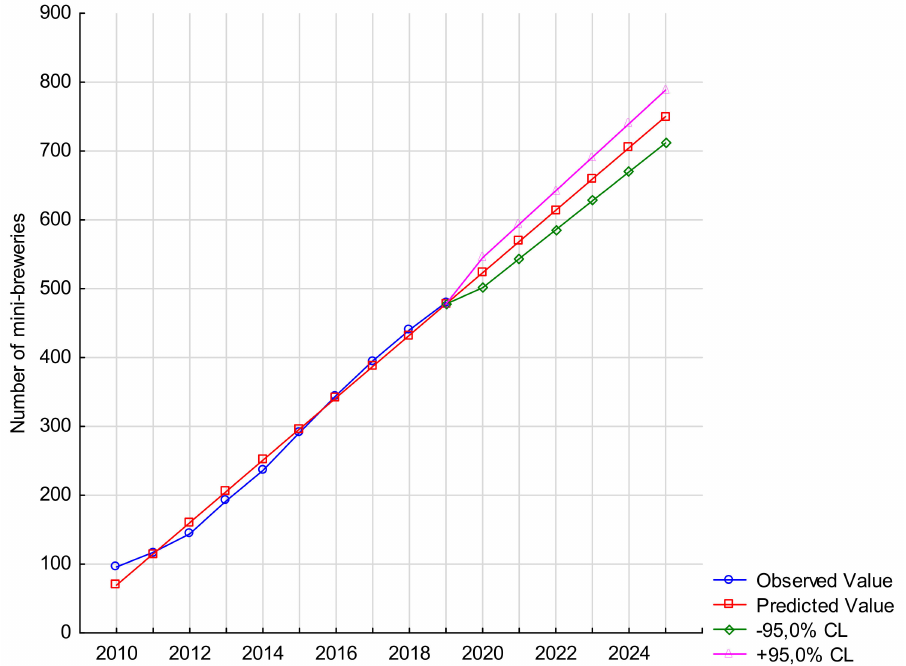
Figure 3. Development of the number of microbreweries in Czechia in the years 2010–2019 and prediction until 2024